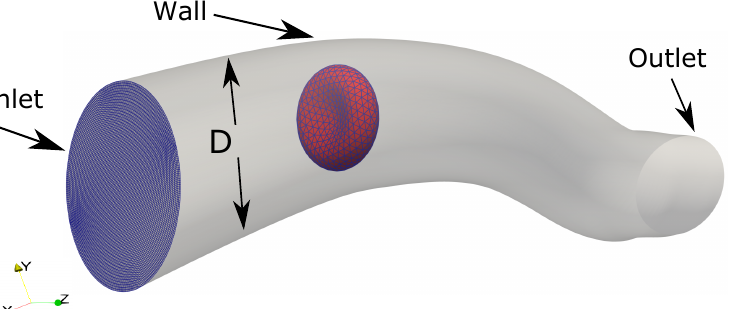
Figure 12. The computational setup for the Fluid-Structure Interaction simulation between a single RBC and the flow in a curved tube, which is a model of a human arteriole. The tube is discretized as a structured grid of size 81 × 81 × 141 with the approximate spacing 0.2 µ m × 0.17 µ m × 0.54 µ m in ( i , j , k ) directions, respectively. The RBC model ( N v = 500) is initially placed at a distance of 20 µ m from the inlet.